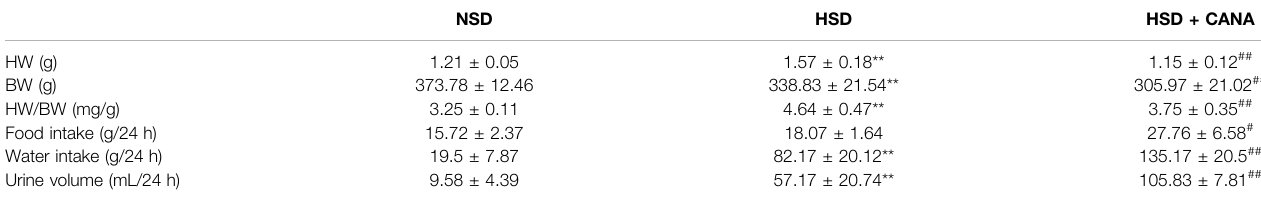
TABLE 2 | Effects of CANA on physiological parameters after treatment for 12 weeks.